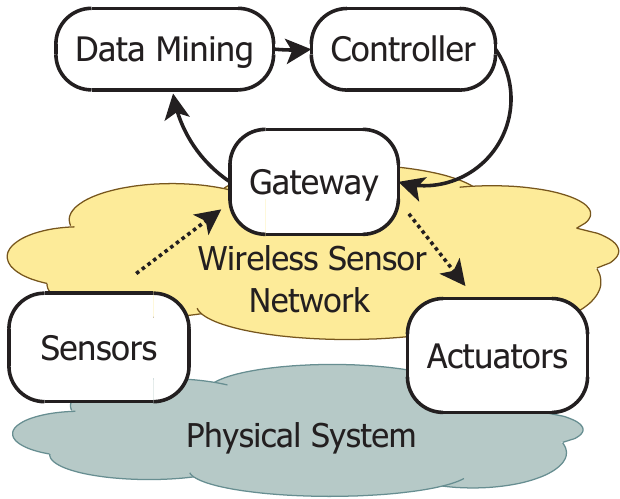
Figure 1. The architecture of the cyber-physical wireless control